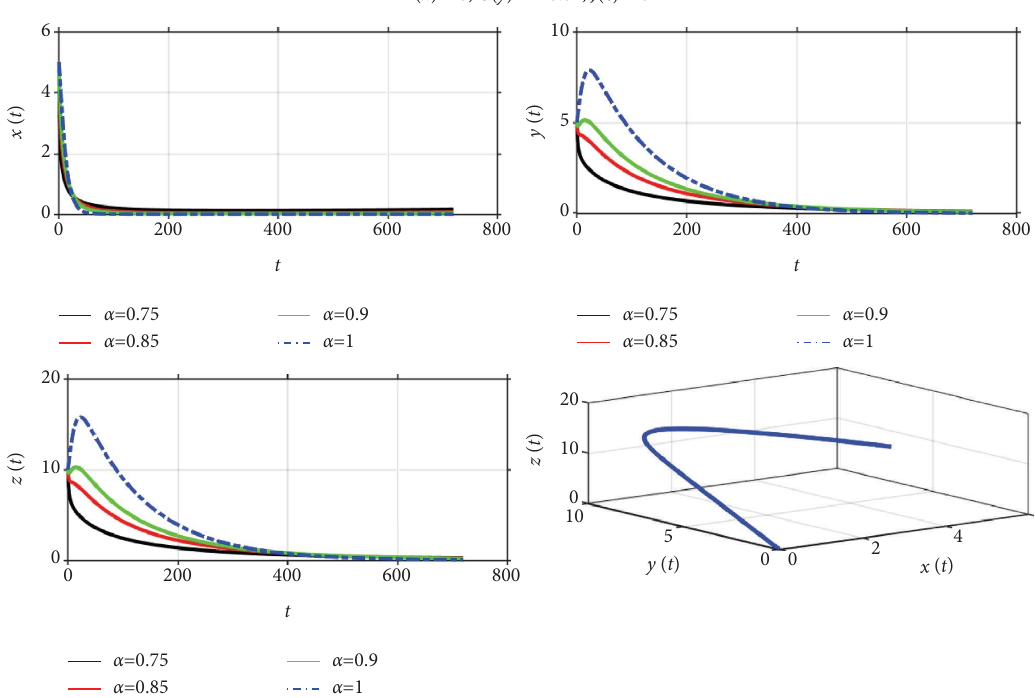
Figure 10: Population dynamics of the one prey-two predators system with D ( x ) � 0 , G ( y ) � − g � − 0 . 01 , J ( z ) � 0 , a � b � c � 0 . 1 , e � h � 0 . 3 , f � i � 0 . 2 , α � 0 . 75 , 0 . 85 , 0 . 9 , 1 , and 3D-plot of x ( t ) , y ( t ) , and z ( t ) for α � 1 .